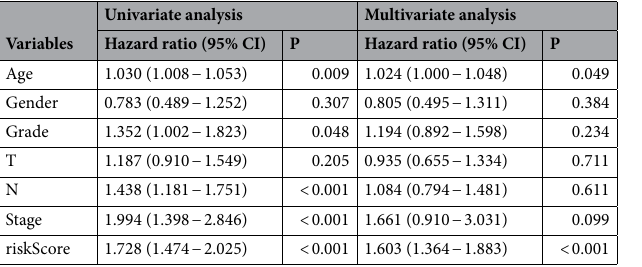
Table 4. Univariate and multivariate independent prognostic analyses of ESCC clinical characteristics based on the prediction